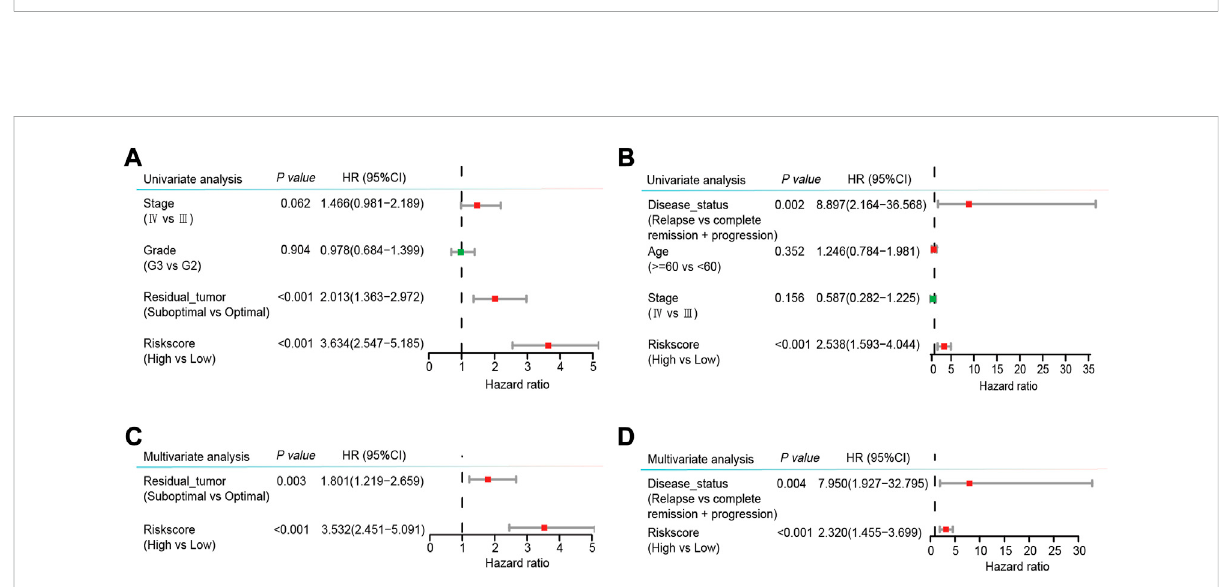
FIGURE 6 Forest plots of univariable (A,B) and multivariable (C,D) Cox regression analyses with HRs and 95% CIs in the GSE32062 cohort (A,C) and the ICGC cohort (B,D) . HR, hazard ratio; CI, con fi dence interval; ICGC, International Cancer Genome